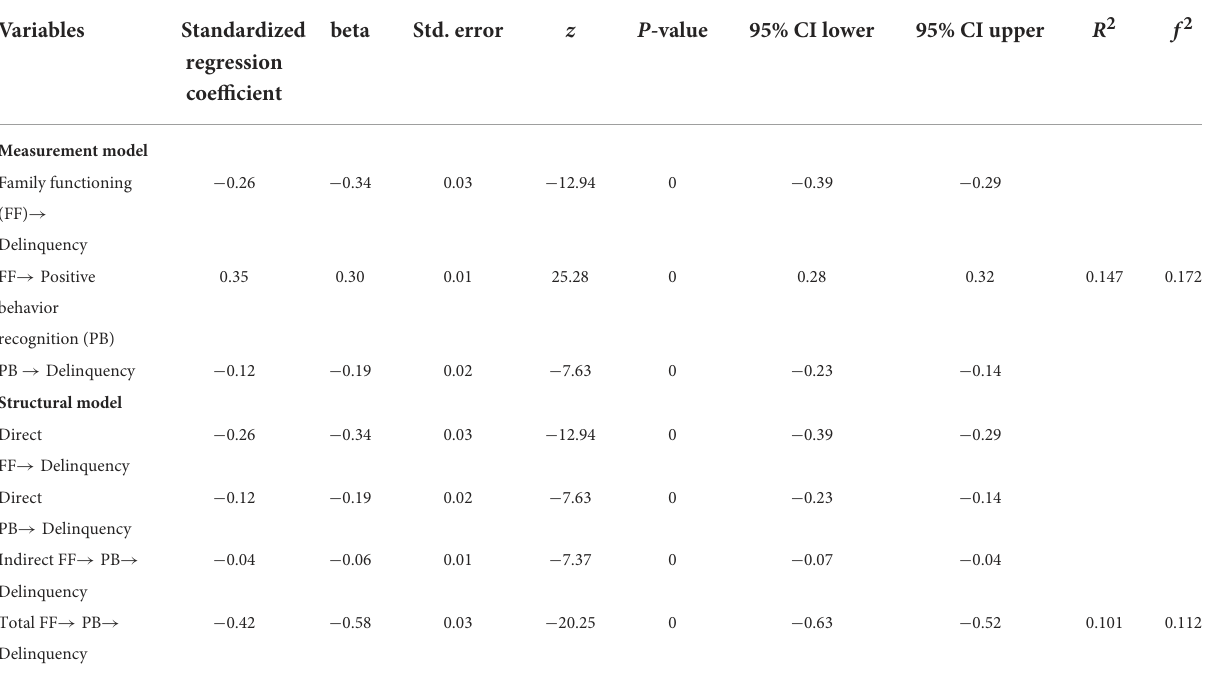
TABLE 4 Presents the path coefficients and indirect effects of family functioning on